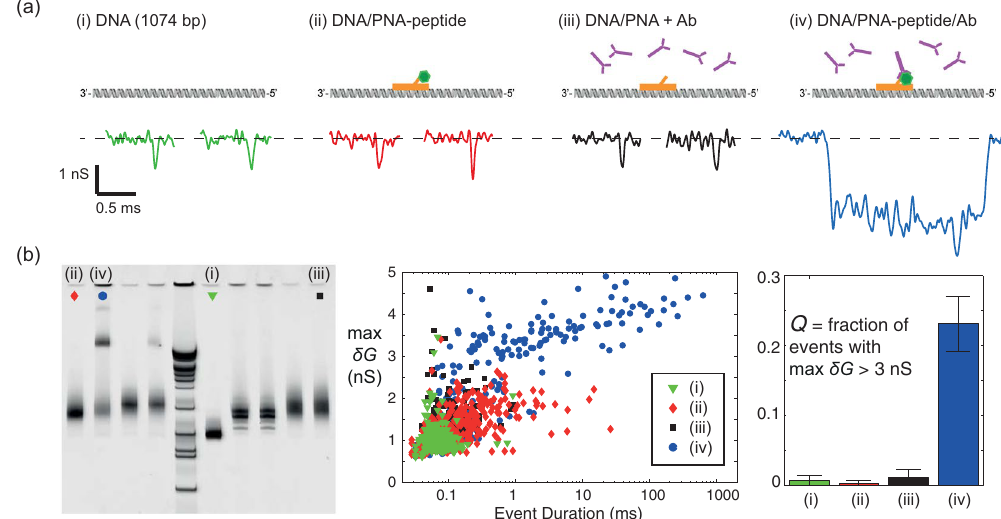
Figure 2. Selective detection of HIV antibody 447-52D using a single nanopore and an engineered detection reagent. ( a ) Contrasting molecular cartoons and recorded nanopore event signatures for (i) DNA alone, (ii) DNA/PNA-peptide detection reagent, (iii) DNA/PNA ( sans peptide) with antibody and (iv) detection reagent bound by antibody. Each reagent (i–iv) was measured sequentially on the same 27 nm diameter pore. In between each reagent, the nanopore was flushed with clean buffer for 5 minutes. The number of events N and recording periods were: (i) N = 332 in 16 min, (ii) N = 434 in 13 min, (iii) N = 353 in 18 min, (iv) N = 441 in 19 min. ( b ) EMSA and nanopore event plots display consistent trends for (i–iv). Unlabelled lanes were not analyzed on the nanopore in this study. The gel upper band that is indicative of full complex (DNA/PNA- peptide/antibody) matches the pronounced increase in nanopore events with larger max δ G values. In particular, while less than 2% of events for (i–iii) are above max δ G = 3 nS, the fraction increases to 23% for full complex (iv), a trend used for positive detection with 99% confidence as described in the main text. The variable Q denotes the fraction of events tagged as target positive, with 99% confidence interval . − Q Q N 2 58 )/